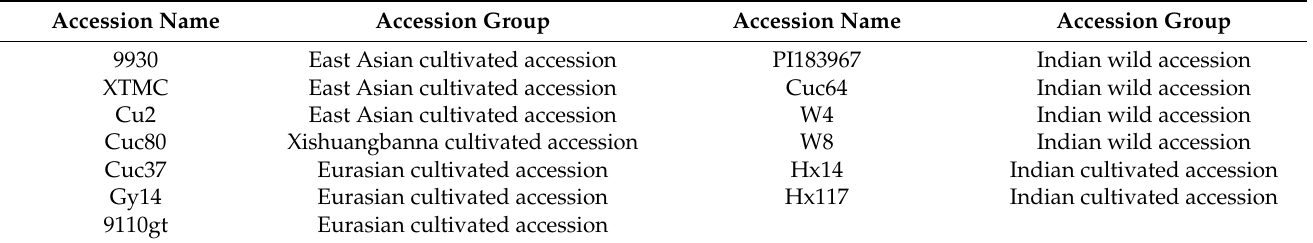
Table 1. The origins of the different cucumber